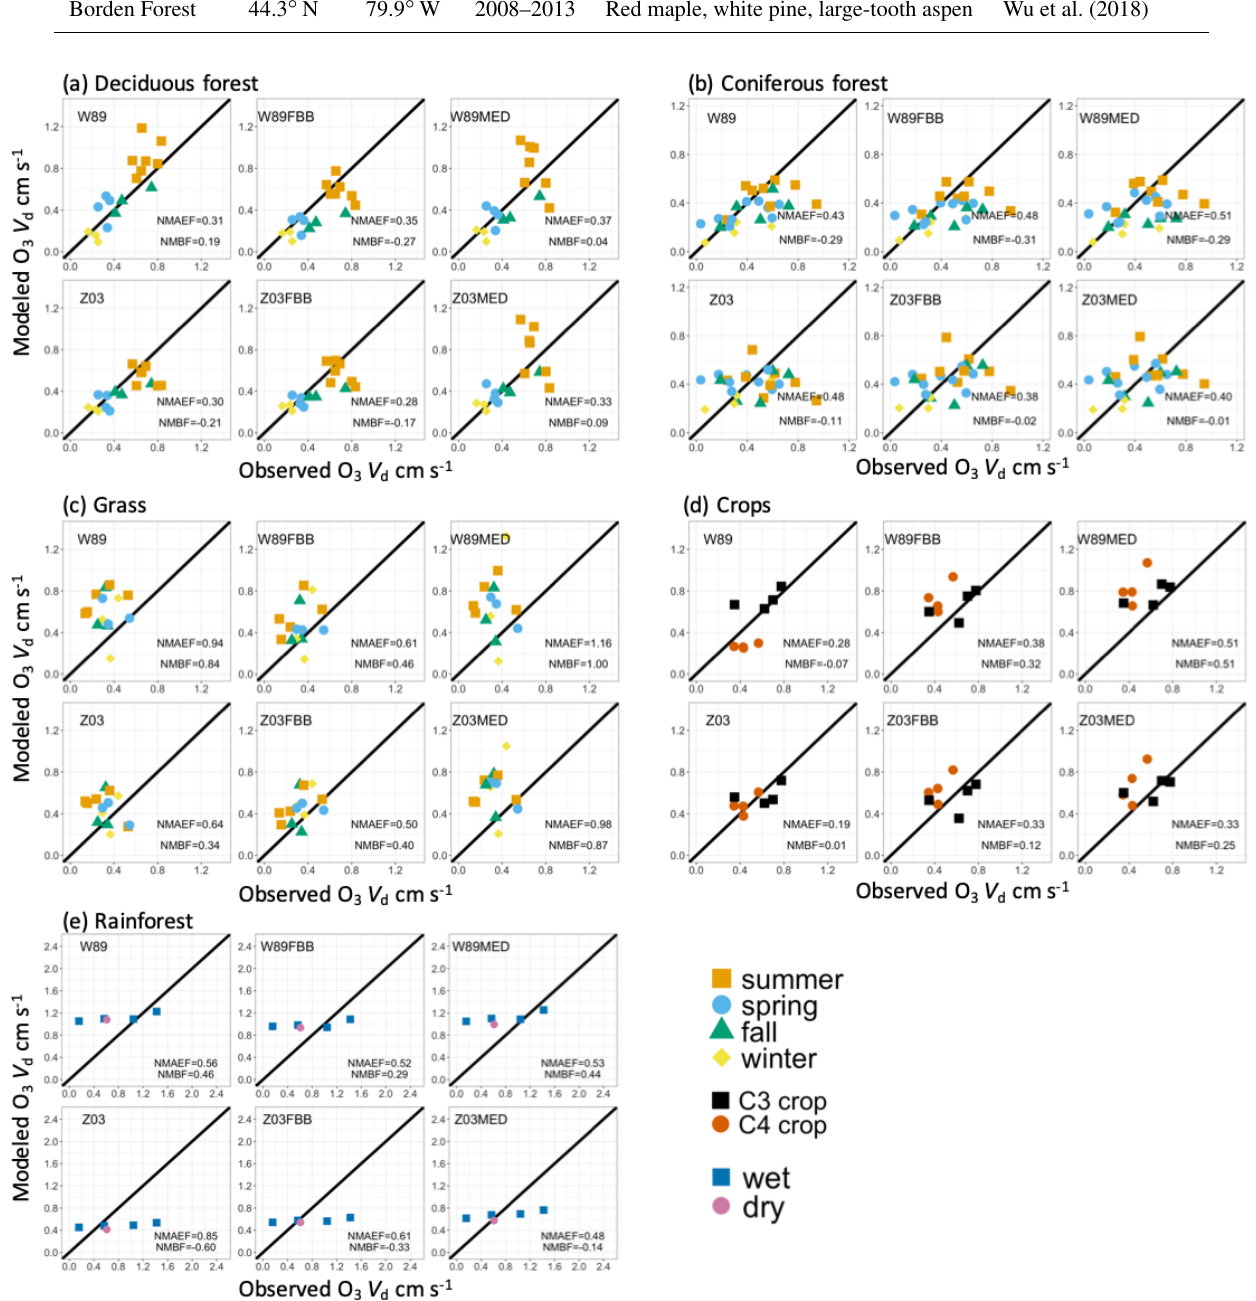
Figure 1. Average daytime (LT 06:00–18:00) observed and simulated dry deposition velocities for five land types. Each data point refers to seasonal average daytime O 3 dry deposition velocity from one dataset listed in Table S1. Colors indicate dominant seasons during field measurements, except for crops where different colors indicate crop types (C 3 and C 4